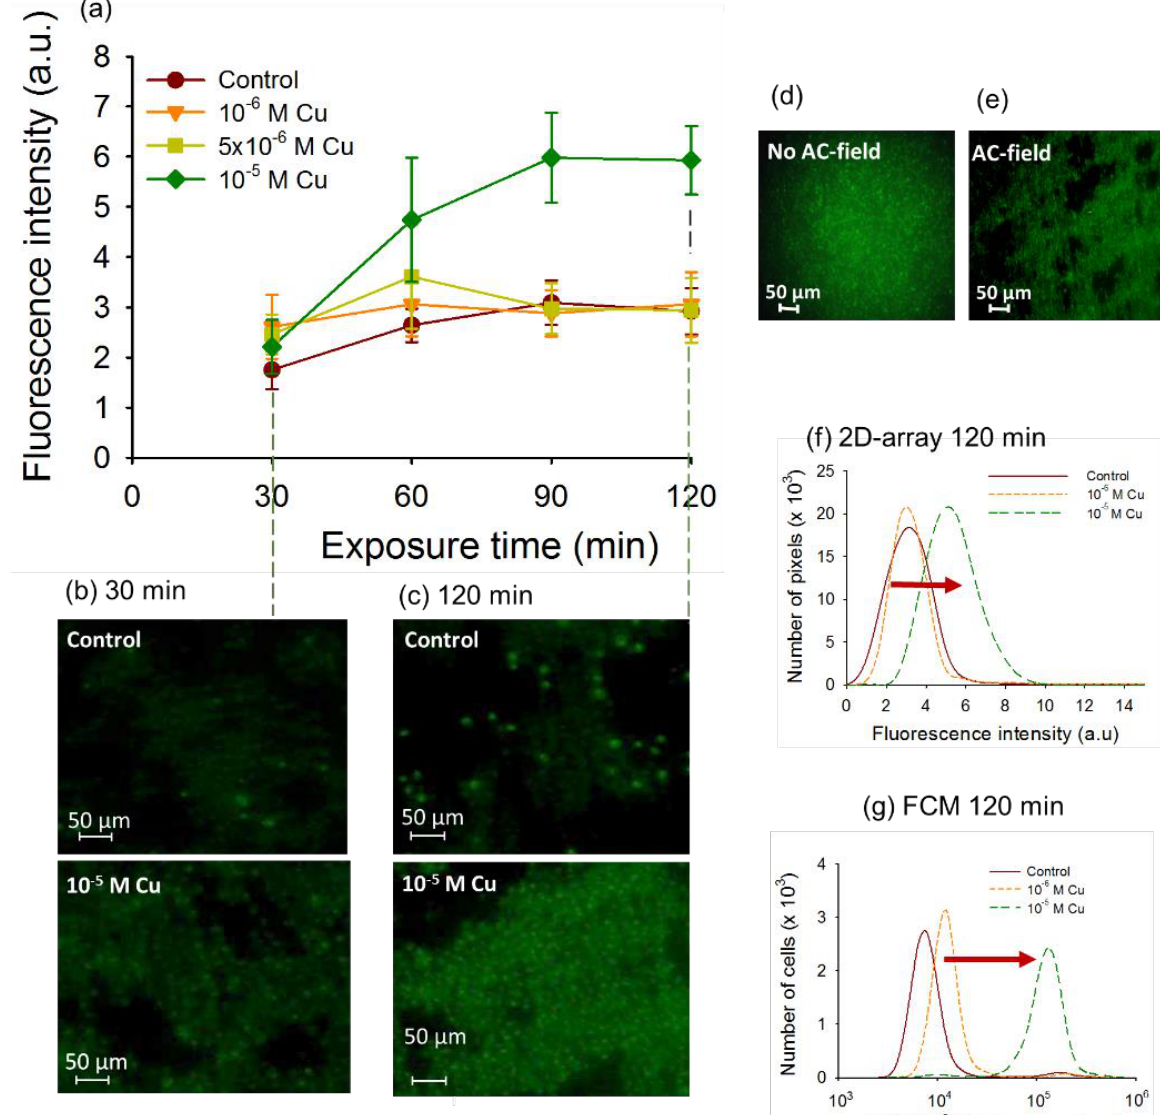
Figure 5. Data for Cu-induced oxidative stress in 2D-assemblies of C. reinhardtii. ( a ) Time course of the mean corrected CellROX ® Green fluorescent intensity ( CF ) per pixel of cells assembled in 2D-arrays by DEP exposed to increasing Cu concentrations; ( b ) Microscopy images of CellROX ® stained 2D-assemblies in the absence and presence of Cu for 30 ( b ) and ( c ) 120 min of exposure; Fluorescence images of CellROX ® stained cells after 30 min of exposure to 10 −5 M Cu ( d ) no AC-field applied and ( e ) AC-field of 100 V·cm −1 and 100 Hz; ( f ) Number of pixels obtained with the 2D-assembly versus corrected fluorescence of CellROX ® Green; ( g ) FCM cytograms for CellROX ® Green for 120 min of exposure. Conditions are the same as for 2D-assembly